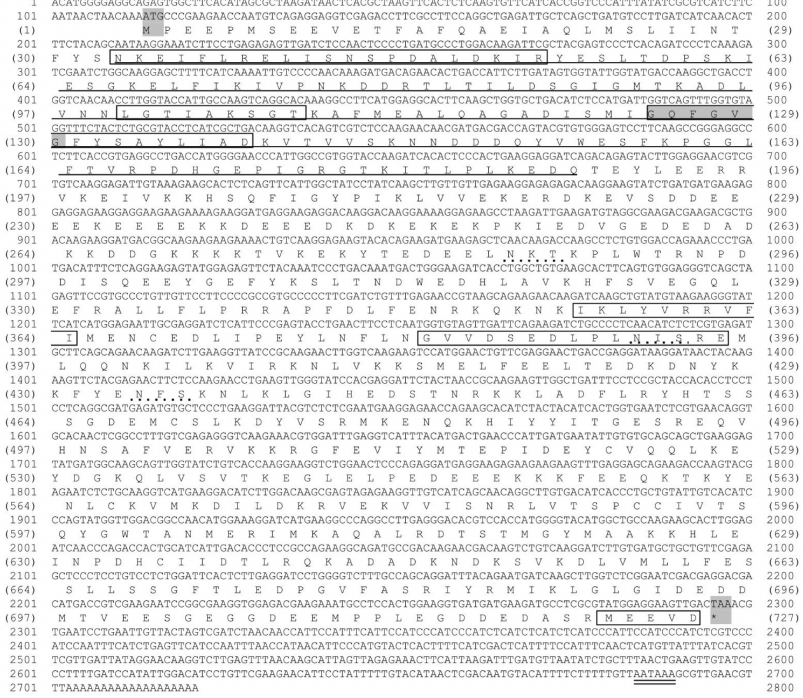
Figure 2. Nucleotide and deduced amino acid sequences of the Mr-hsp90 gene. All five con- served amino acid motifs defining the hsp90 family signature (NKEIFLRELISN[S/A]SDALDKIR, and the consensus sequence MEEVD at the C-terminus were present in the hsp90 sequence and are shown in the open box. The ATPase domain of hsp90 is underlined. N-linked glycosylation sites are shown by points. The polyadenylation signal site (AATAAA) is double